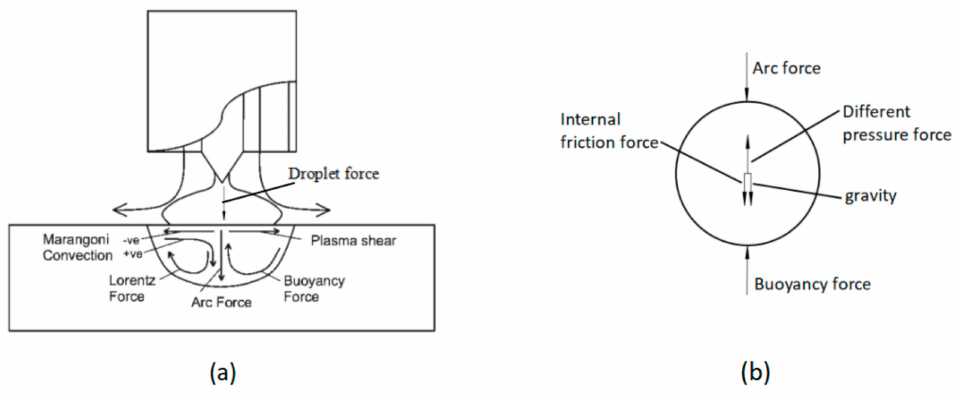
Figure 4. ( a ) Forces acting on liquid weld metal and ( b ) forces acting on a bubble in molten